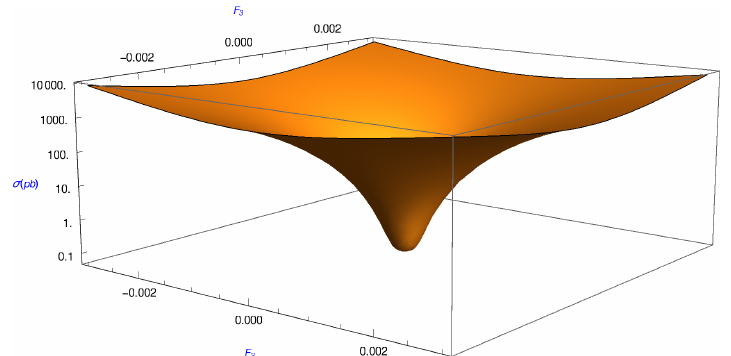
(cid:112) s = 33 TeV . electric dipole moment τ